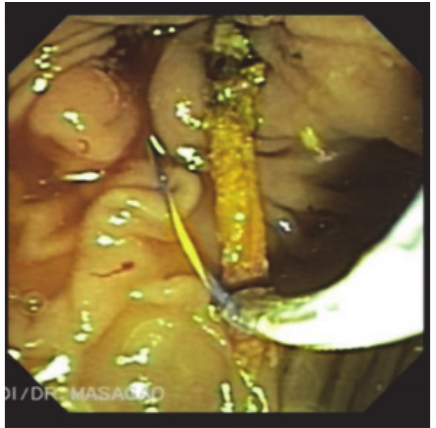
Figure 3: Extraction of a partially intact toothpick with a trapezoid basket.